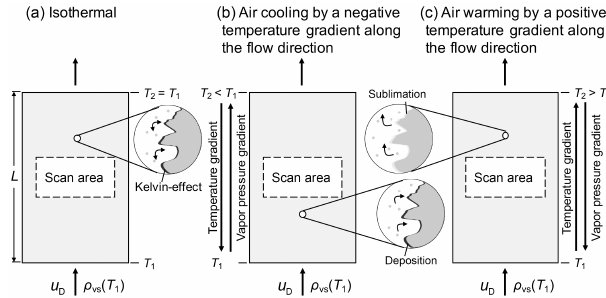
Figure 1. Schematic of the ice–air interface transport processes. (a) Under isothermal conditions, the Kelvin effect leads to a satura- tion of the pore space in the snow but does not affect the structural change (Ebner et al., 2015a); (b) air cooling by a negative temper- ature gradient along the flow direction leads to a change in the mi- crostructure due to deposition (Ebner et al., 2015b); (c) air warming by a positive temperature gradient along the flow has a negligible total mass change of the ice but a strong reposition effect of water molecules on the ice grains, shown in this